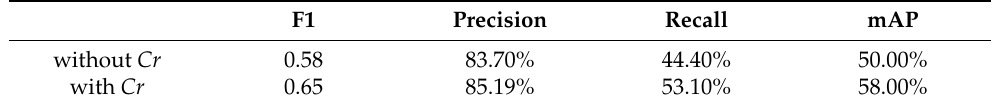
Table 2. Comparison of evaluation indexes of enhanced YOLOv5s.